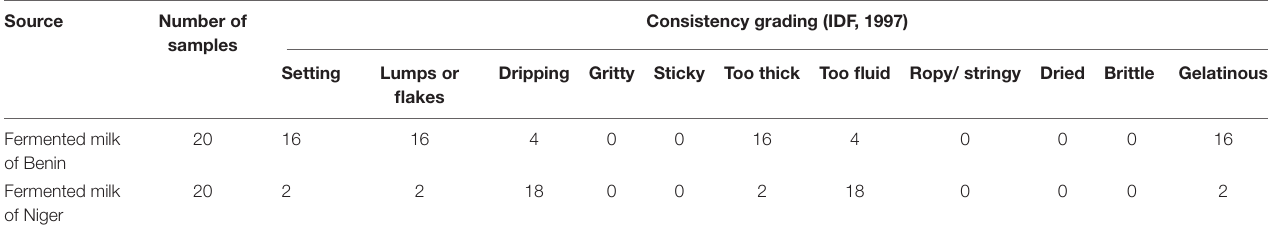
TABLE 3 | Difference in the consistency of the naturally fermented milk products marketed in Benin and Niger.